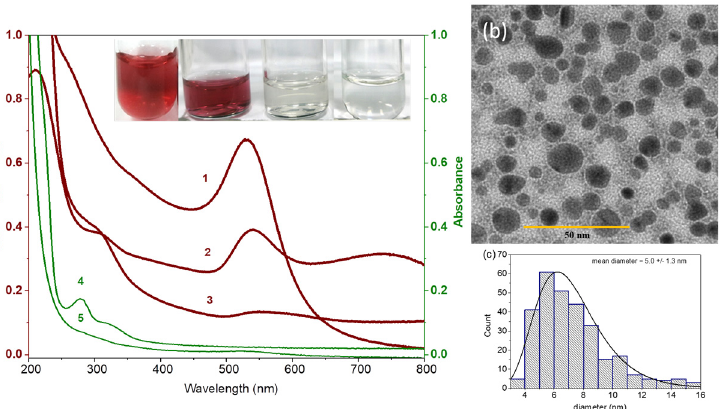
Figure 2. Characterization of nanoparticles. ( a ) UV-Vis spectra of NanoBro colloidal suspension produced with HEPES- buffered Bro (line 1), with HEPES and sodium phosphate (line 2), with aqueous solution of Bro (line 3). Green lines 4 and 5 correspond, respectively, to the spectra of HEPES-buffered Bro (0.2 mg/mL) and the supernatant of NanoBro synthesis (line 1) obtained by GNPs precipitation by centrifugation. The inset shows, from left to right snapshots of solutions 1–4. Spectra were obtained 4 days after the synthesis; ( b ) transmission electron microscopy (TEM) of NanoBro was obtained with magnification of 100.000× and energy of 80 kW; ( c ) histogram of NanoBro size distribution fitted as lognormal curve by Origin tool calculated a mean diameter of of 5.0 ± 1.3